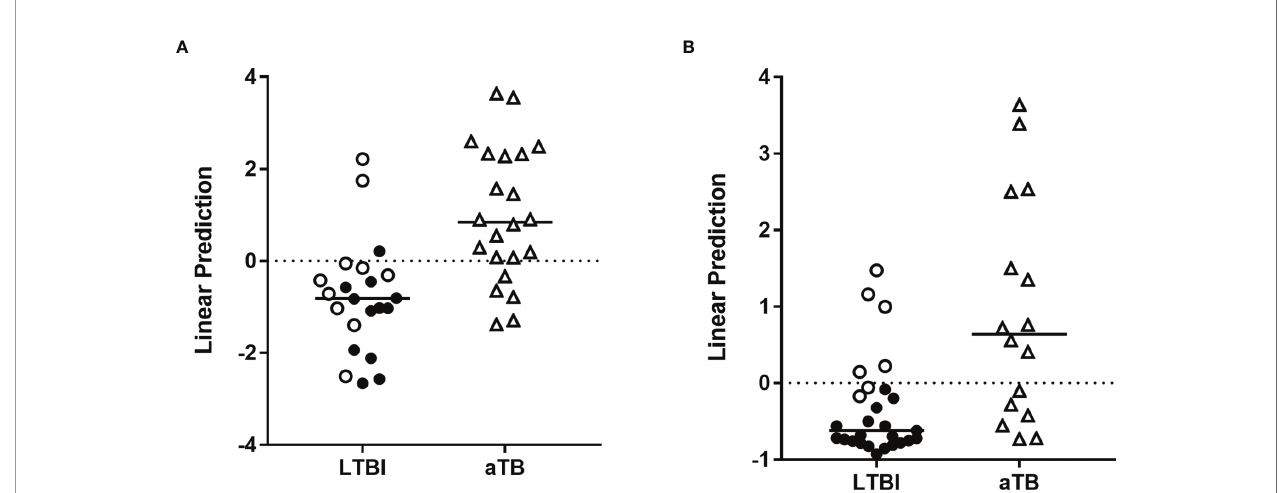
FIGURE 3 | Combination of M. tuberculosis -speci fi c immune markers allowing the distinction between LTBI and aTB in the PBMC assay. HBHA-IFN- g and ESAT-6- IP-10 were the markers selected by logistic regression analysis to be combined for the PBMC-based assay to discriminate aTB from LTBI. Patients with aTB are indicated by open triangles and LTBI subjects at risk to reactivate the infection by open circles. Results are represented with their linear predictor for the validation (A) and training (B) cohorts. The horizontal lines represent the medians and the dotted lines arbitrary cut-offs.